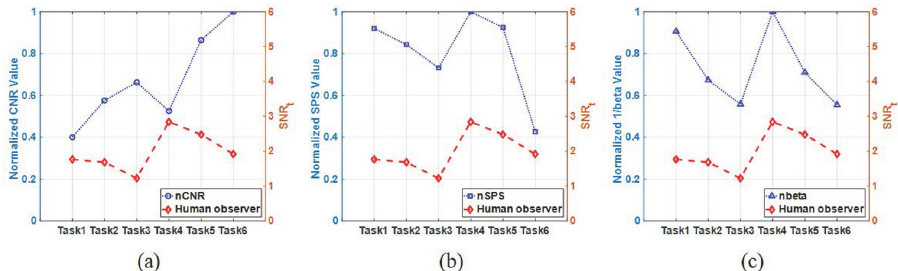
Fig 9. Comparison results between human observer and traditional metrics. Comparison between human observer results and normalized values of (a) CNR (nCNR), (b) SPS (nSPS), and (c) the inverse of β value (nbeta).